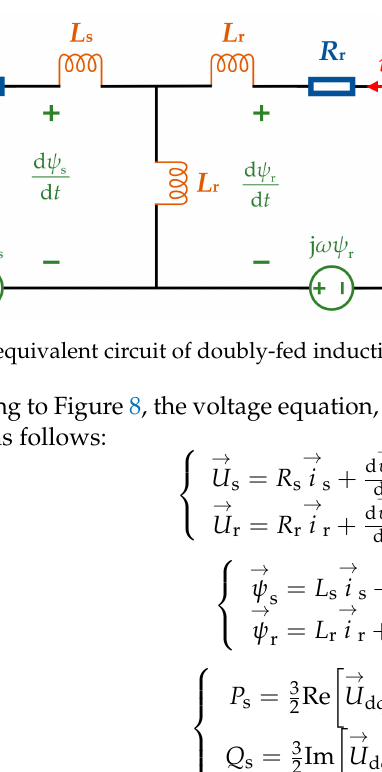
Figure 7. The topology of DFIG.